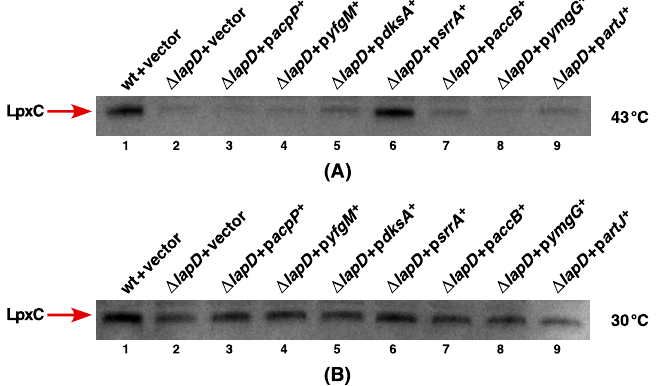
Figure 14. The impact of overexpression of various multicopy suppressor encoding genes in Δ lapD bacteria on the levels of LpxC. Immunoblots of whole cell lysates obtained from isogenic strains grown either at 30 ◦ C, following a temperature shift for 2 h at 43 ◦ C ( A ) or when grown at 30 ◦ C ( B ). For immunoblotting, LpxC-specific antibodies were used and the relevant genotype is indicated. An equivalent amount of total proteins was resolved by an SDS-PAGE prior to immunoblotting. Note the restoration of LpxC levels when the srrA gene is overexpressed, particularly at 43 ◦ C.